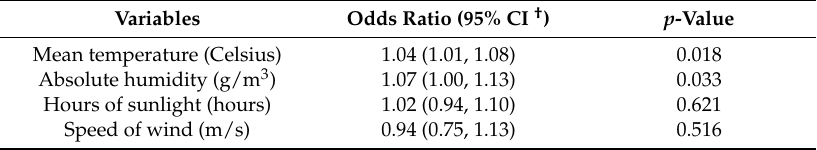
Table 1. Univariate association between the incidence of Bacillus spp. and climatological variables.